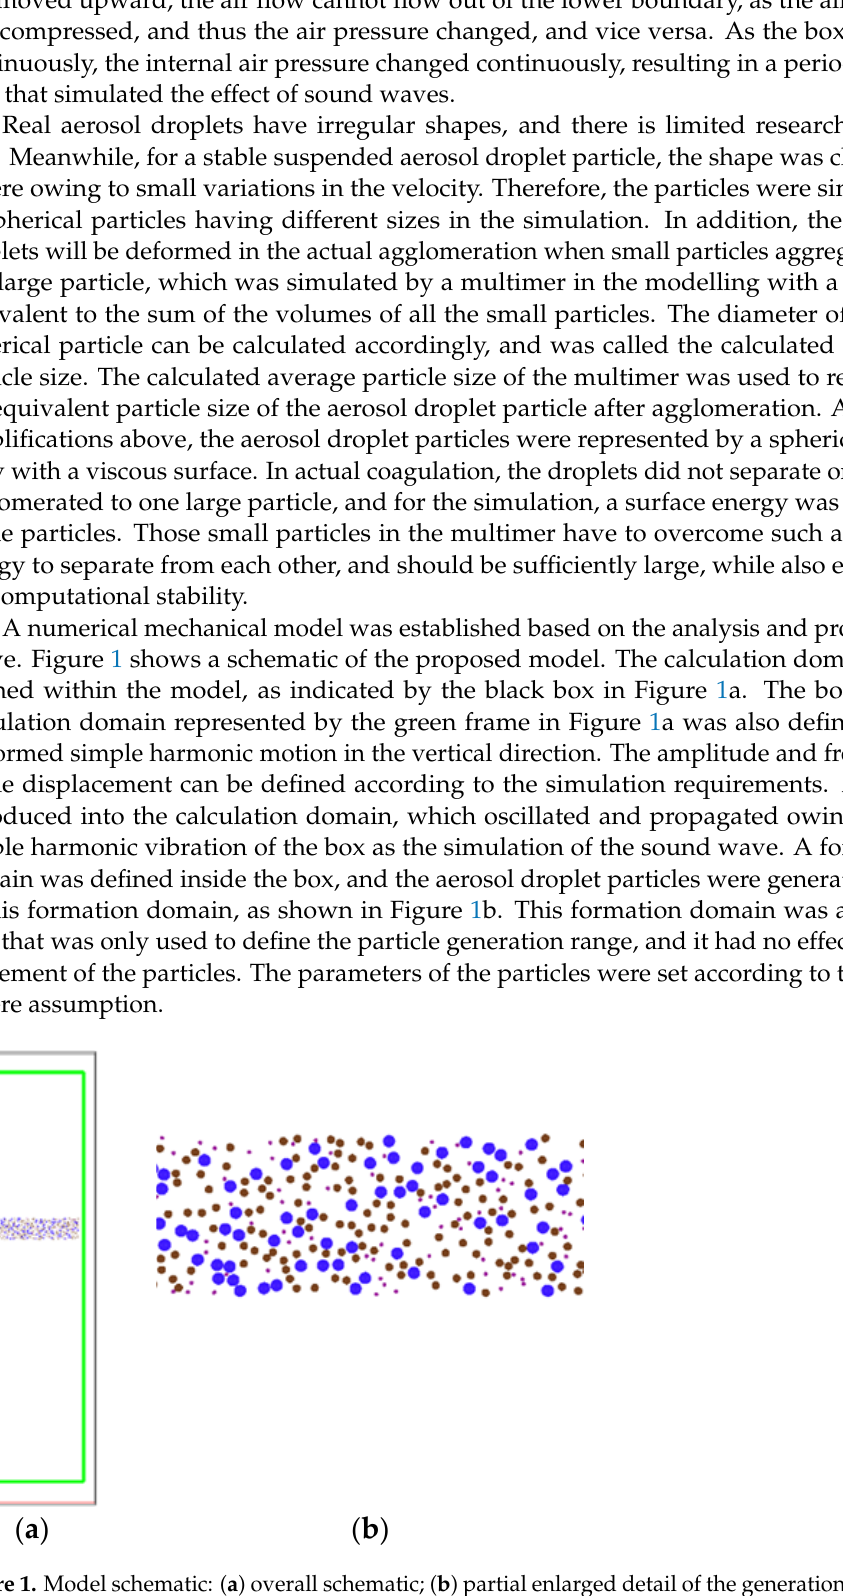
Figure 1. Model schematic: ( a ) overall schematic; ( b ) partial enlarged detail of the generation domain.